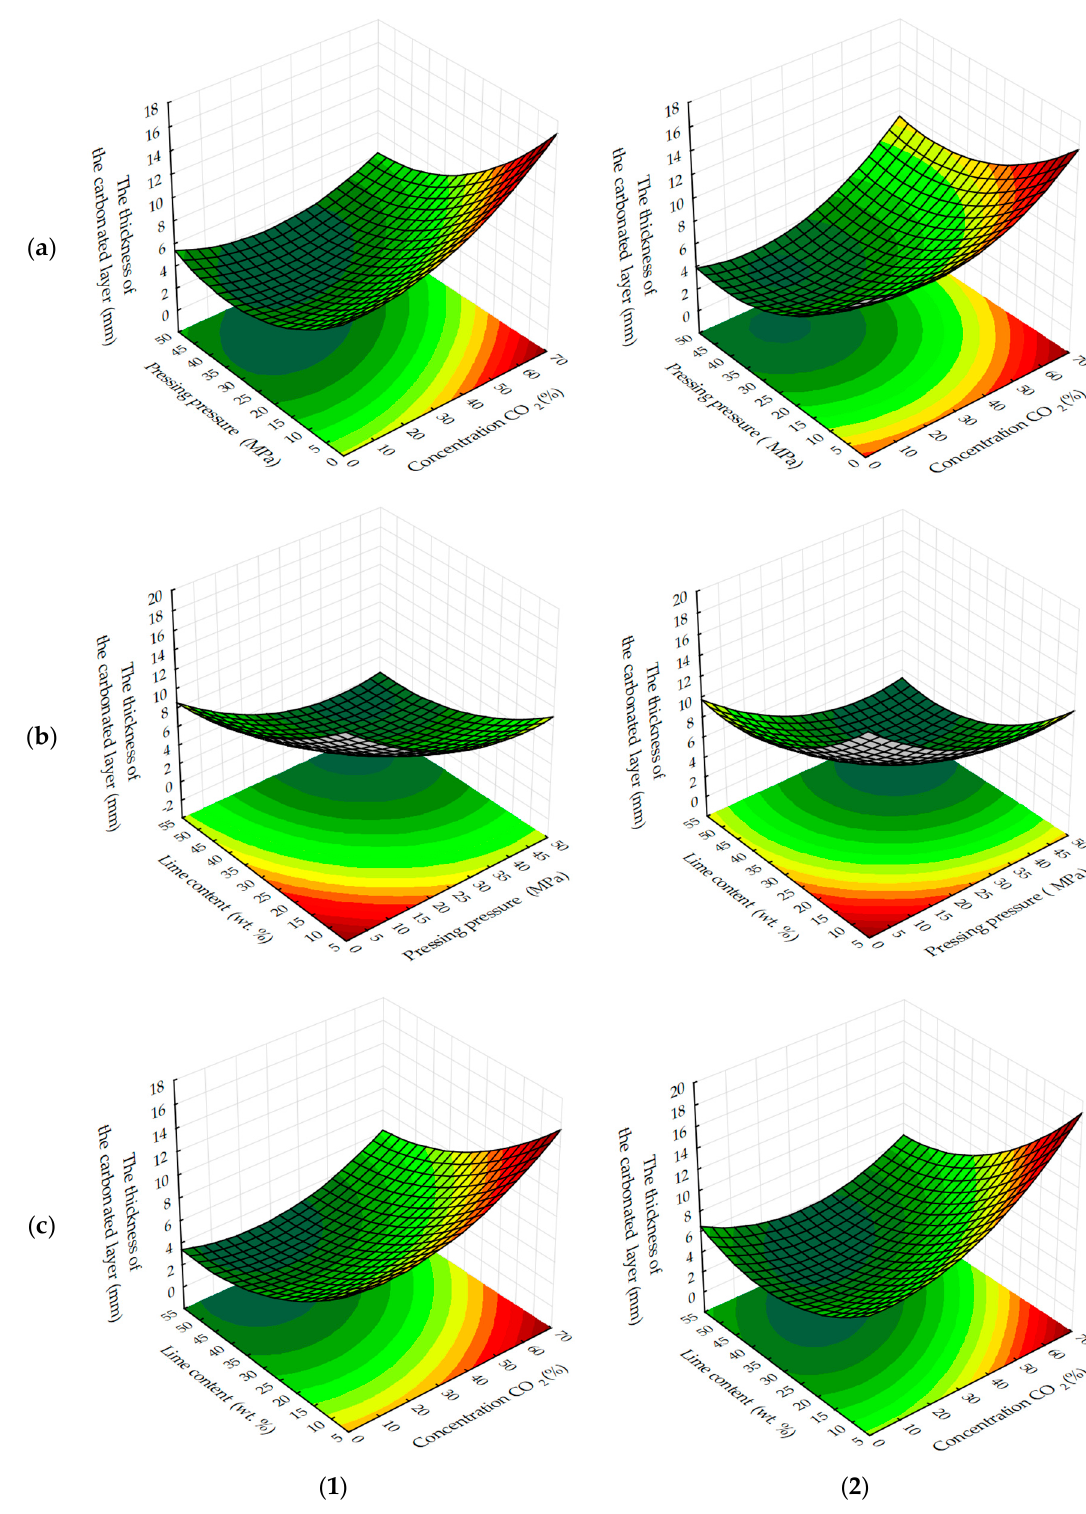
Figure 11. Response surfaces to changes in the thickness of the carbonated layer of testing samples carbonated by dynamic ( 1 ) and static ( 2 ) methods, depending on: ( a ) the molding pressure and the concentration of CO 2 ; ( b ) the content of lime dust and molding pressure pressing; ( c ) the content of lime dust and the concentration of CO 2 (at zero level of variation of other factors).